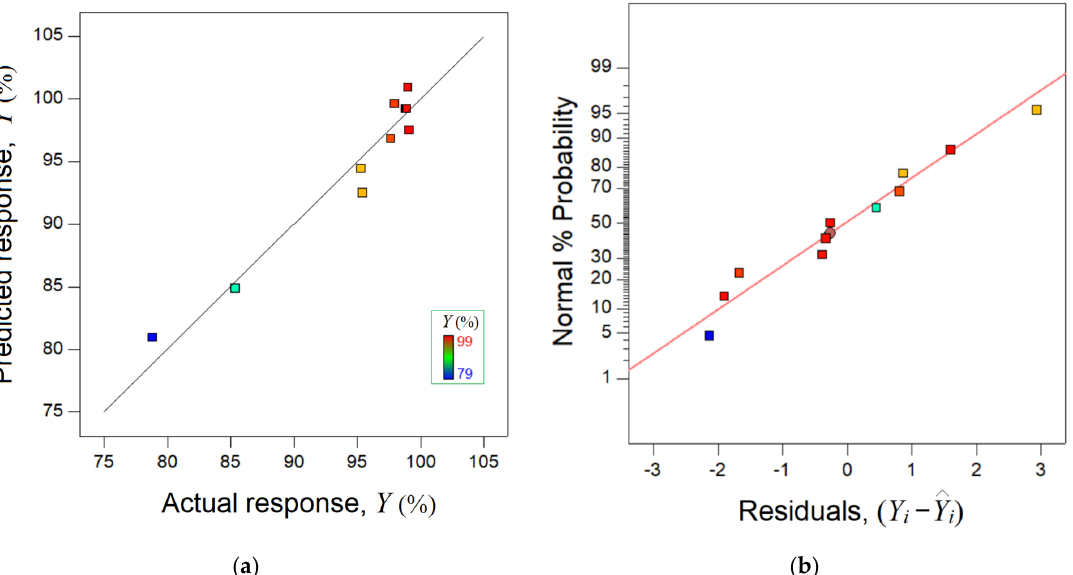
Figure 7. Concordance between experimental data and the predictions given by the model: ( a ) parity plot, and ( b ) normal plot of residuals.